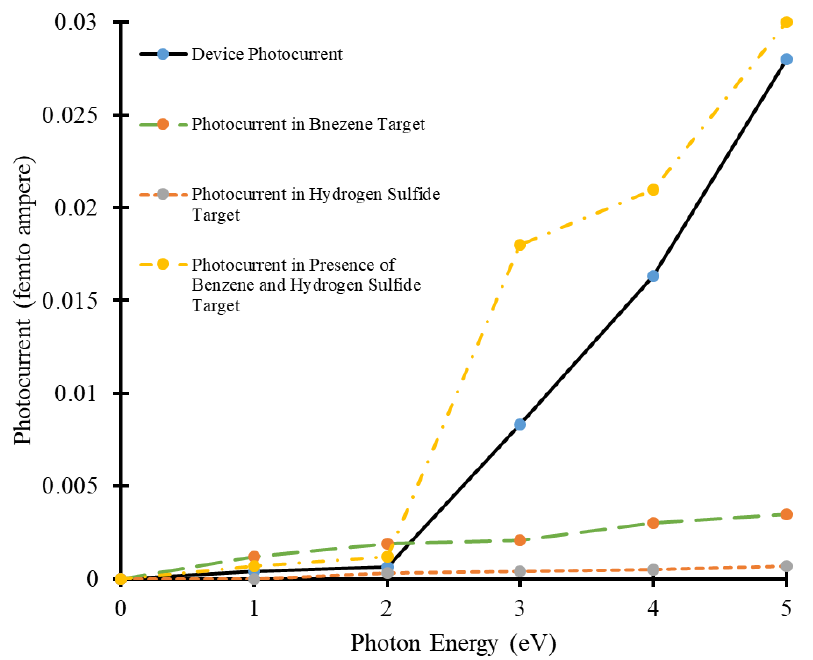
Figure 6. Photon energy vs. photocurrent curves of carbon nanotube-based device in presence of benzene and hydrogen-sulfide target molecules.